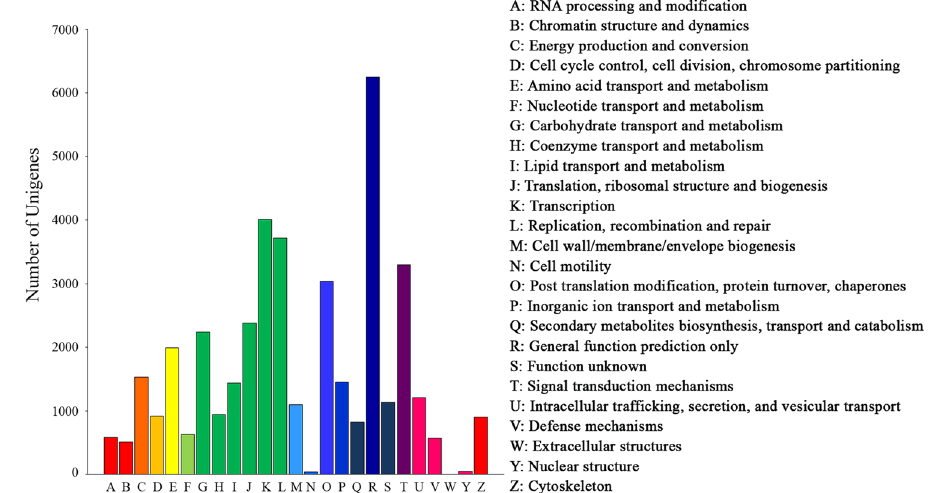
Figure 2. EuKaryotic Orthologous Groups (KOG) in Capparis spinosa leaf transcriptome. The unigenes with significant homologies in the KOG database were grouped into 24 categories. The number of unigenes belonging to each category was reported in the y-axis, while the subgroups in the KOG classification were represented in the